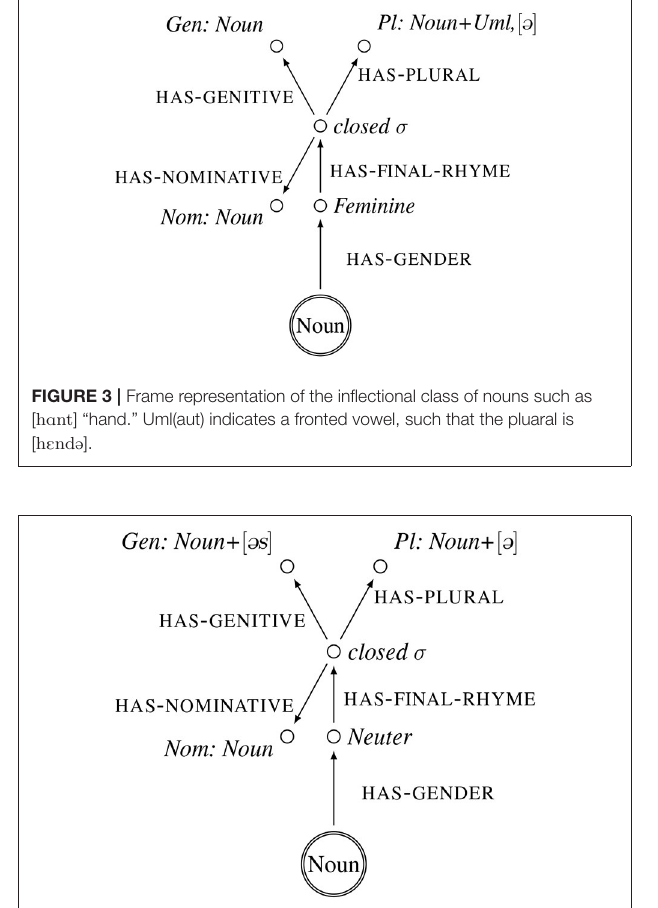
FIGURE 4 | Frame representation of the inflectional class of nouns such as [ bot ] “boat.” There are only one or two neuter words in this class with umlaut in the plural (Köpcke, 1988; Thieroff and Vogel, 2009).